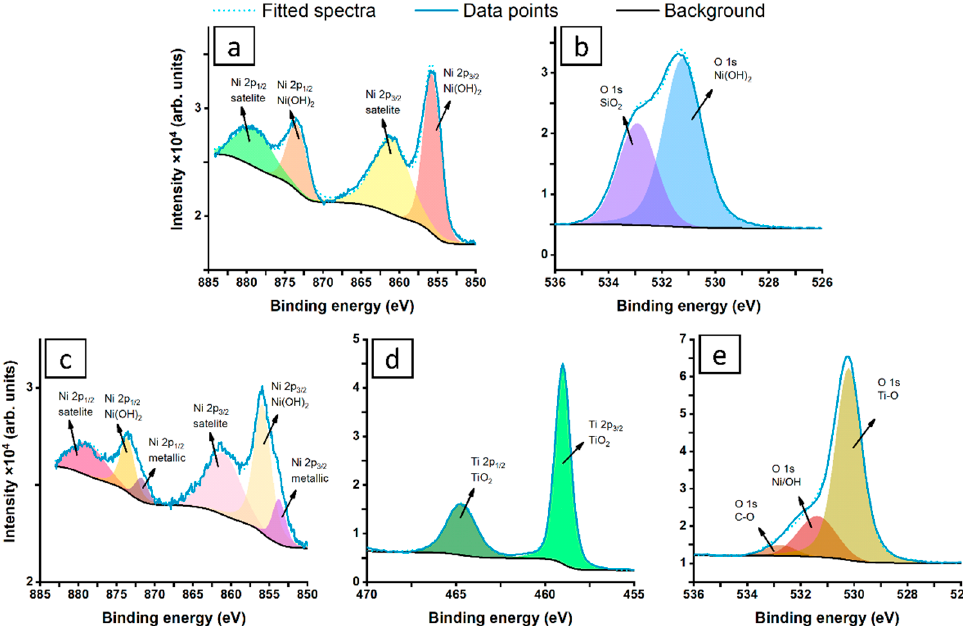
Figure 4. Deconvoluted XPS spectra for nickel nanoparticles placed on Si wafer ( a , b ), and onto titania nanotubes ( c – e ). Measurements were performed in the energy range of nickel ( a , c ), oxygen ( b , d ), and titanium ( e ).